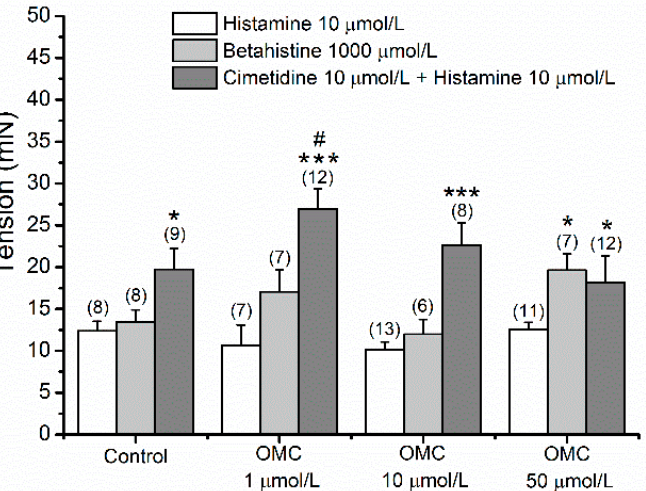
Figure 6. Tension (at time 15 min) of the human umbilical artery (HUA)-rings incubated with octylmethoxycinnamate (OMC) and contracted by histamine (Hist; unspecific agonist of Hist receptors; 10 µ mol/L), betahistine (BHI; H 1 agonist; 1000 µ mol/L), and joint application of cimetidine (H 2 antagonist; 10 µ mol/L) and Hist (10 µ mol/L). Each bar represents the mean, vertical lines represent the S.E.M. and the number within brackets represents n . * Represents a significant difference when compared to the tension induced by the Hist: * ( p < 0.05) and *** ( p < 0.001); # represents a significant difference when compared to the tension of control group: # ( p < 0.05); two-way ANOVA method followed by Holm–Sidak post-hoc